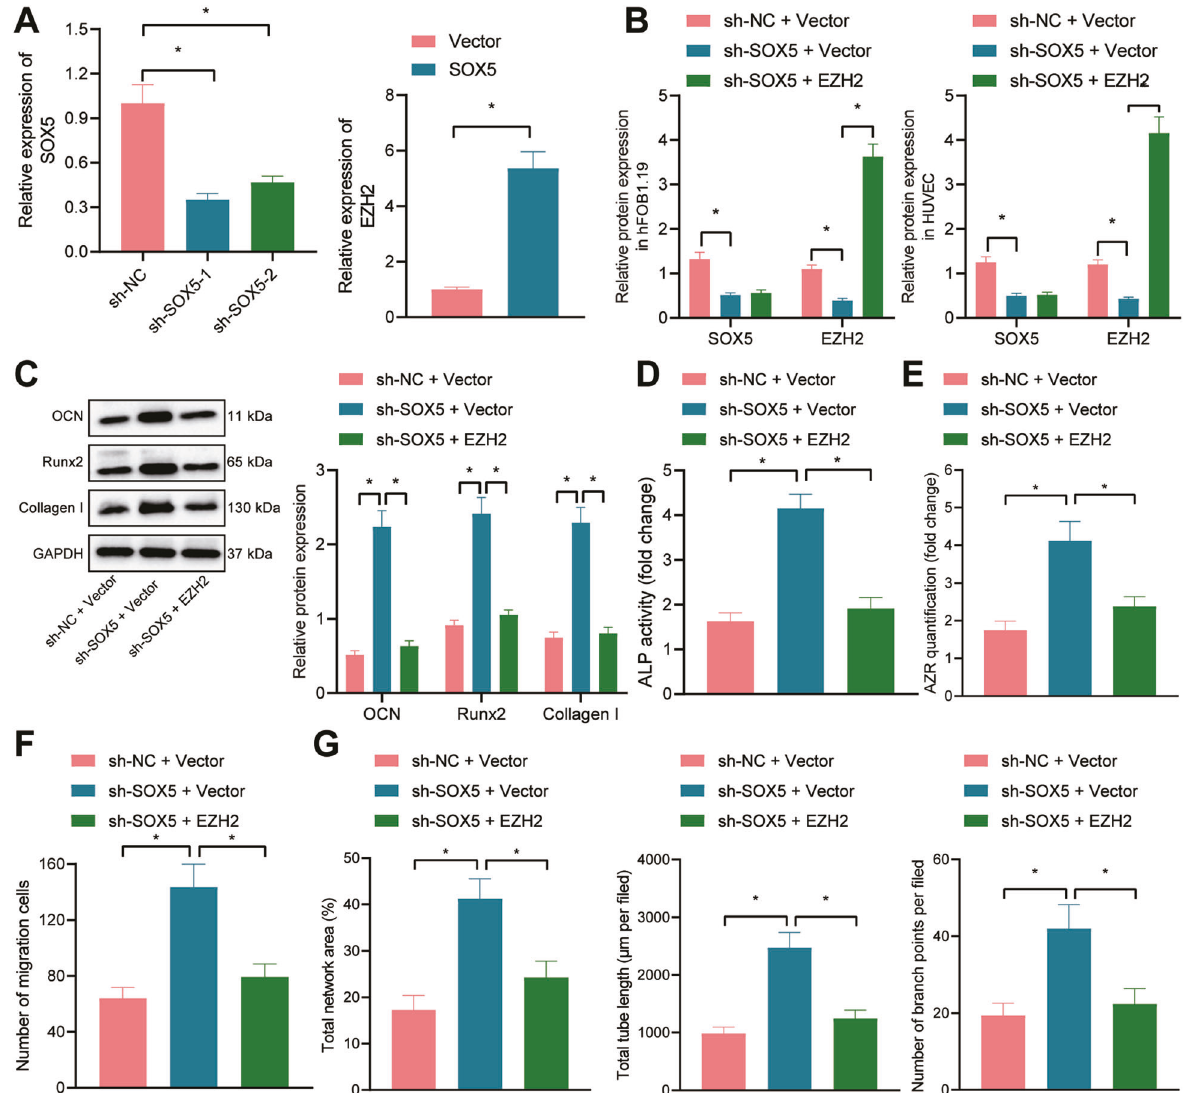
Fig. 3 SOX5 inhibits HUVEC angiogenesis and hFOB1.19 cell osteogenesis by promoting EZH2 expression. A The transduction ef fi ciency of SOX5 and EZH2 in cells validated with RT-qPCR; B immunoblotting analysis of the expression of SOX5 and EZH2 cells; C immunoblotting analysis of the expression of osteogenesis-related markers (OCN, Runx2, and Collagen I) in hFOB1.19 cells; D quantitative analysis of ALP activity of hFOB1.19 cells; E quantitative analysis of calcium deposition of hFOB1.19 cells by alizarin red S staining; F the migration of HUVECs determined with Transwell assay; G the tube-forming ability of HUVECs with total network area, total length, and the number of branch points determined with capillary-like tube formation assay. Cell experiment was repeated three times independently. * p <